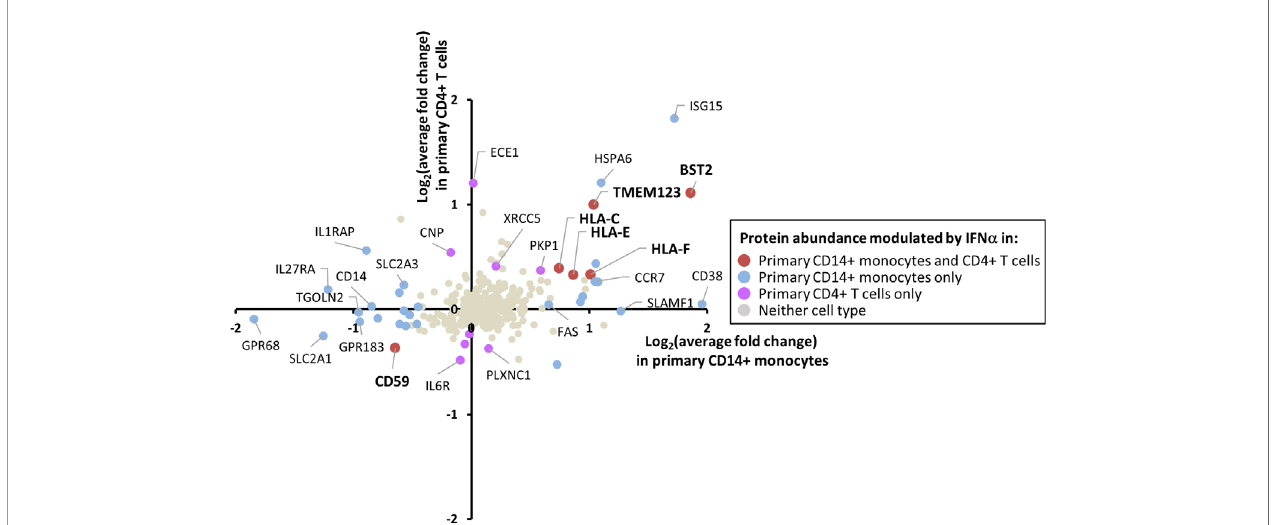
FIGURE 4 | Comparison of the effects of IFN a 2a on the plasma membrane (PM) proteome of primary CD14+ monocytes and CD4+ T cells. Comparison of data for 284 proteins quanti fi ed in both CD14+ monocytes and CD4+ T cells. These 284 proteins include 280 proteins described in Figure 2C and additionally classical class I and class II HLA molecules. Proteins are de fi ned as modulated by IFN a 2a according to the previously de fi ned criteria (FC > 1SD from the mean, and FC > 1 in all donors for upregulation, FC < 1 in all donors for downregulation). Full data is shown in Tables S1 and S4H . Certain proteins including ISG15 did not meet cut- offs for upregulation by IFN a 2a in CD4+ T cells due to inconsistent upregulation across donors ( Table S1